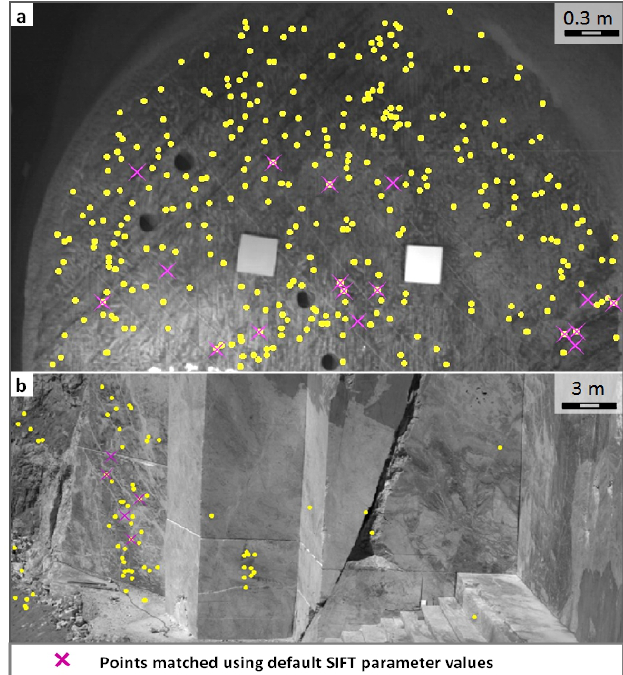
Figure 11. Points matched using SIFT with default and optimized parameter values shown in Table 3. ( a ) Image N-A2. ( b ) Image P-C3, 6 scales per octave